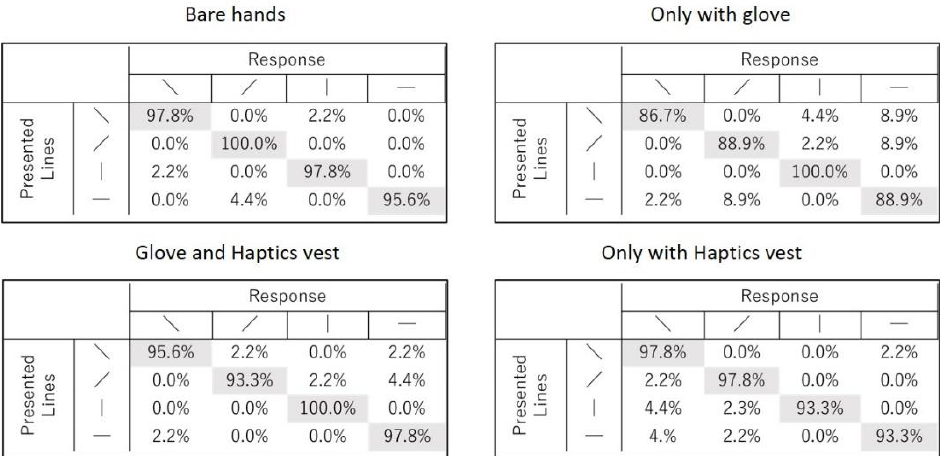
Figure 10. Results of experiment 1